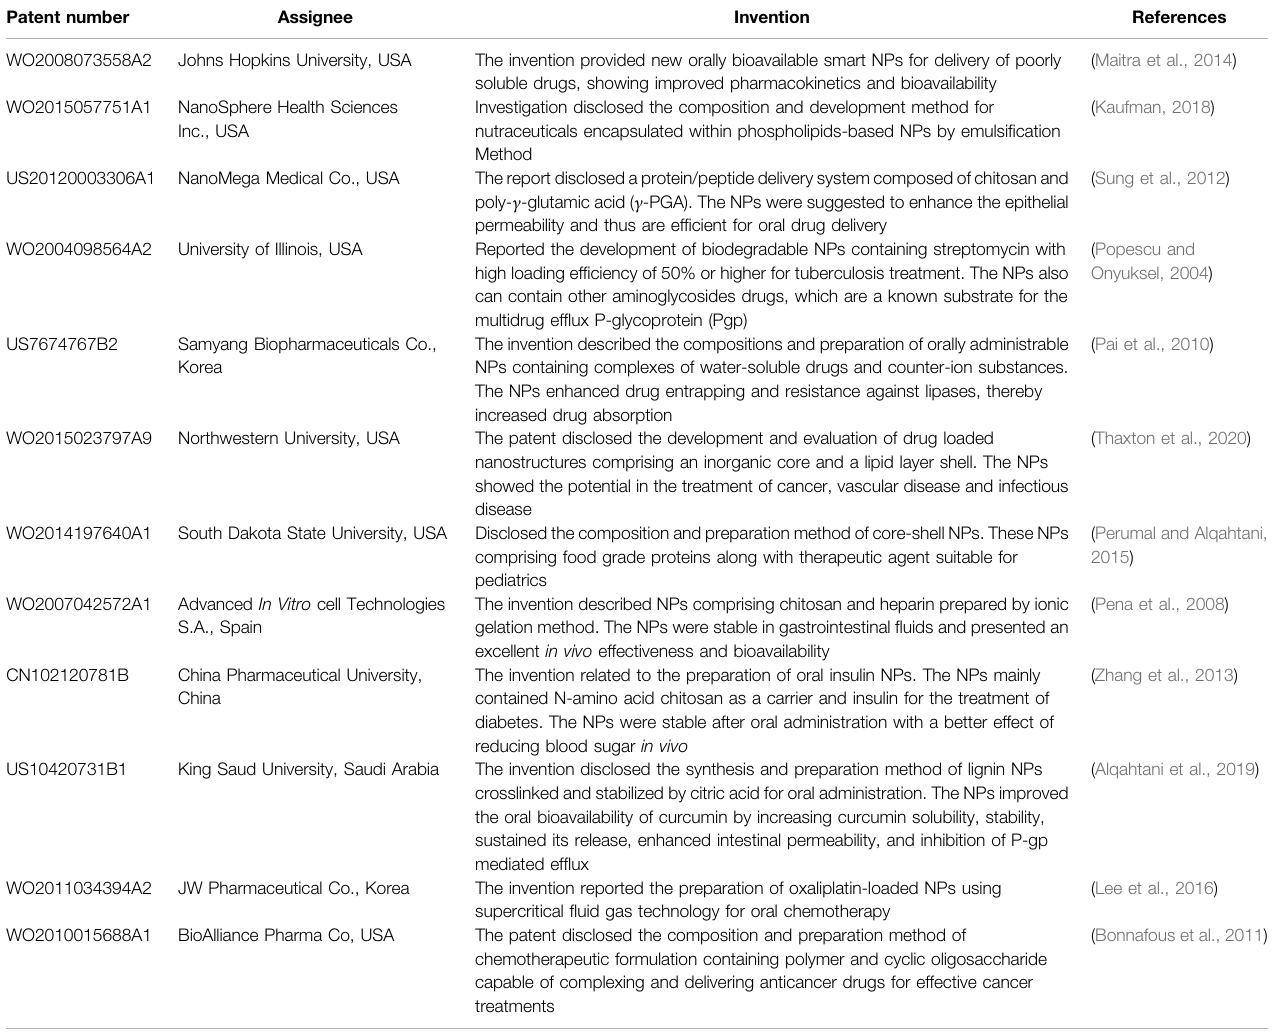
TABLE 10 | List of patented formulations related to nanoparticles for oral drug